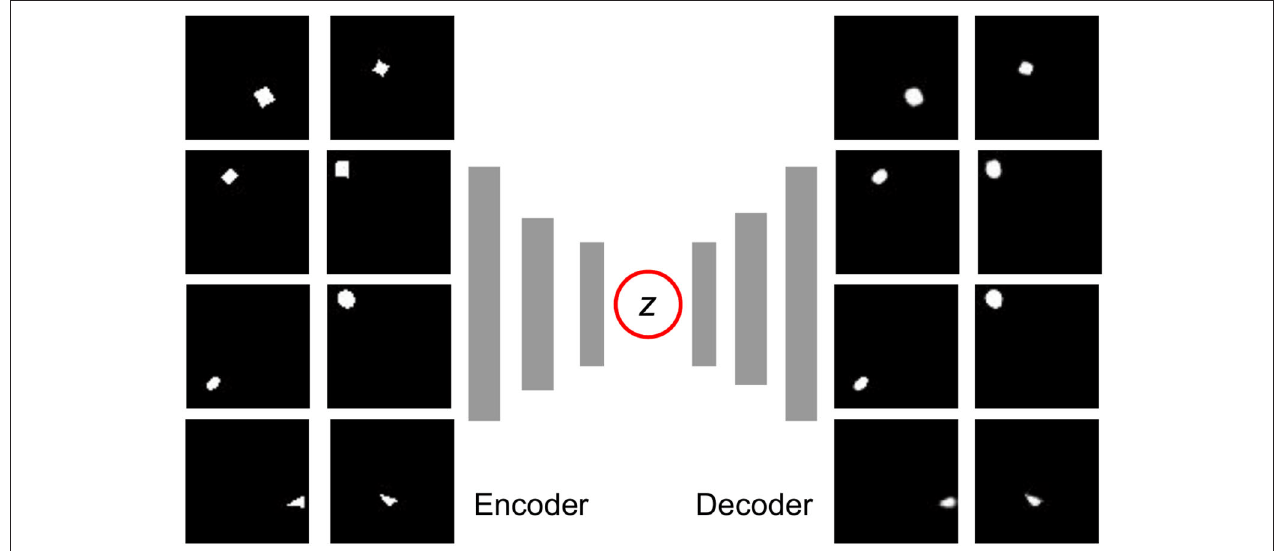
FIGURE 4 | The training dataset (left) and reconstruction (right) of the Variation Autoencoder (VAE). All of the images are sized 64x64. The dataset includes 20,000 images, and all the object samples are illustrated in Figure 5 . As we can see, the position and general shape are well reconstructed, even though some details such as the rotation angle and sharp corners are not exactly the same as the originals.